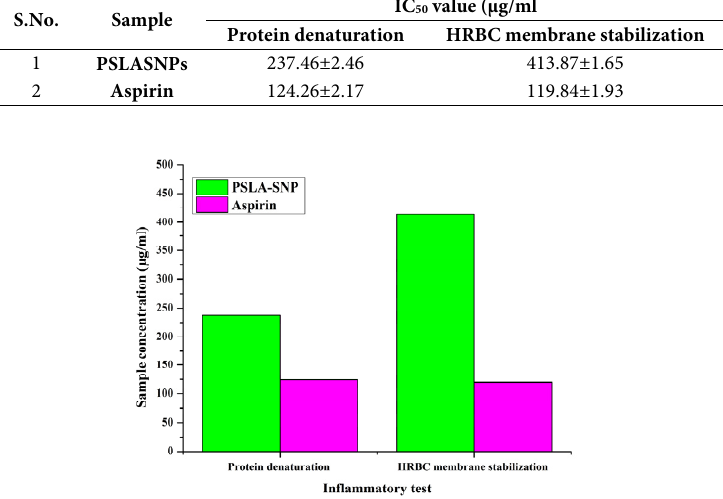
value of PSLASNPs 50